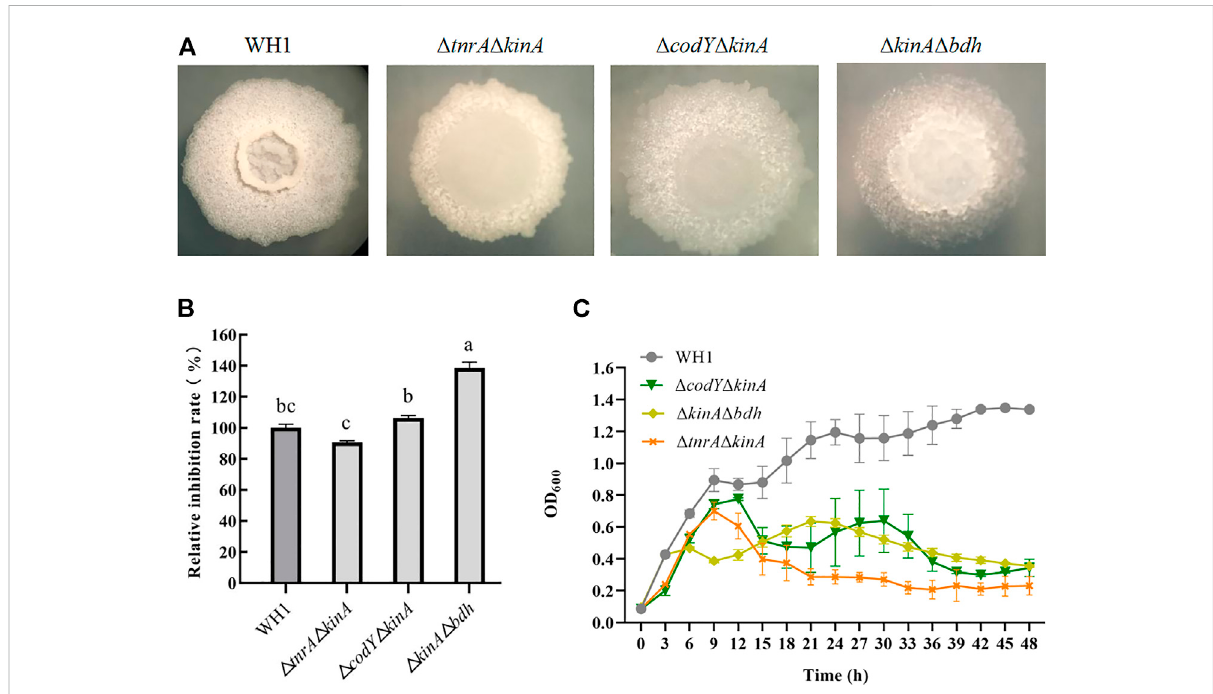
FIGURE 4 Relative inhibition rates and characteristics of double-knock strains. (A) : Colony morphology; (B) : Relative inhibition rates; (C) : Growth